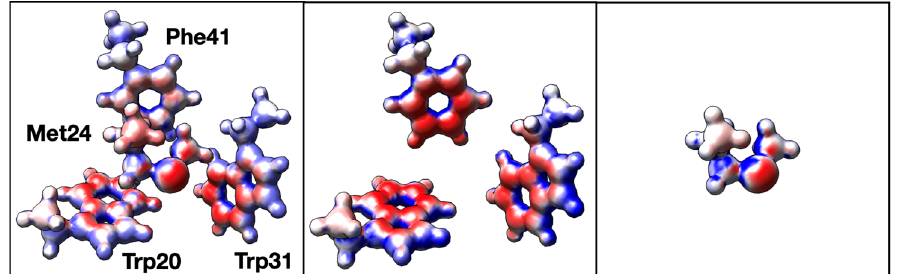
Figure 4. Electron density plots for the 3-bridge cluster in cytochrome P450 from T. bispora (PDB ID 5VWS). The ( left ) panel shows the complete bridge, the ( center ) shows the aromatic groups only, and the ( right ) panel shows Met only. Red corresponds to a charge of − 0.03, white is zero, and blue is +0.03. The image was generated using UCSF Chimera.